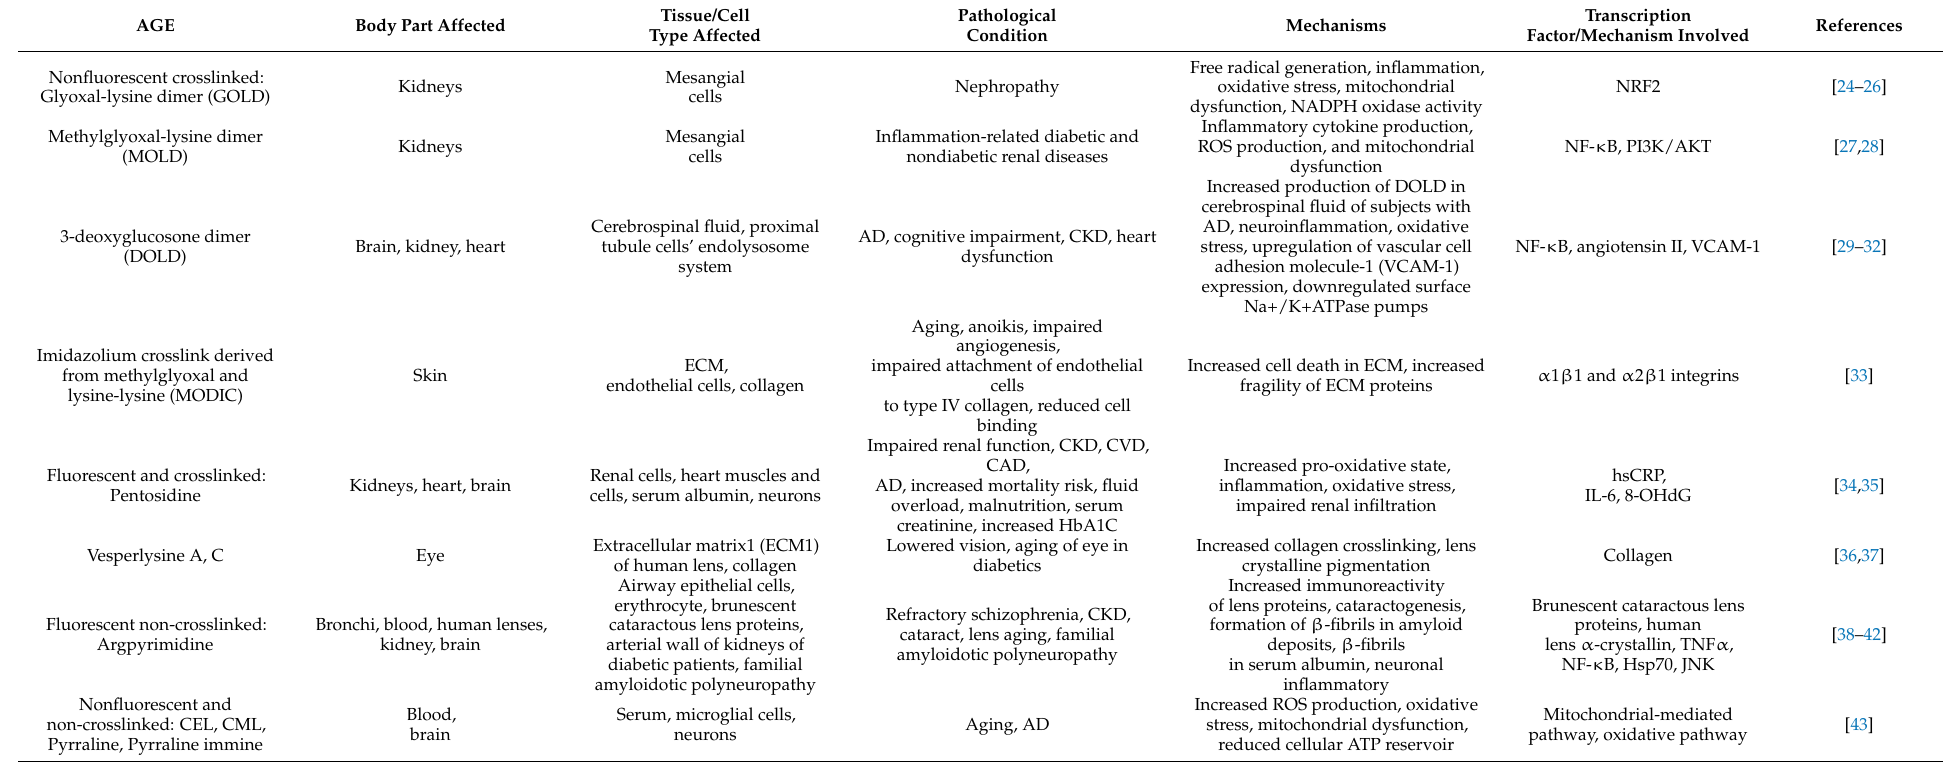
Table 1. The most frequent AGEs in the hyperglycemic condition. AGEs are produced or accumulated in different body parts at different rates and concentrations which augment different pathological conditions via induction of different molecular pathways and transcription